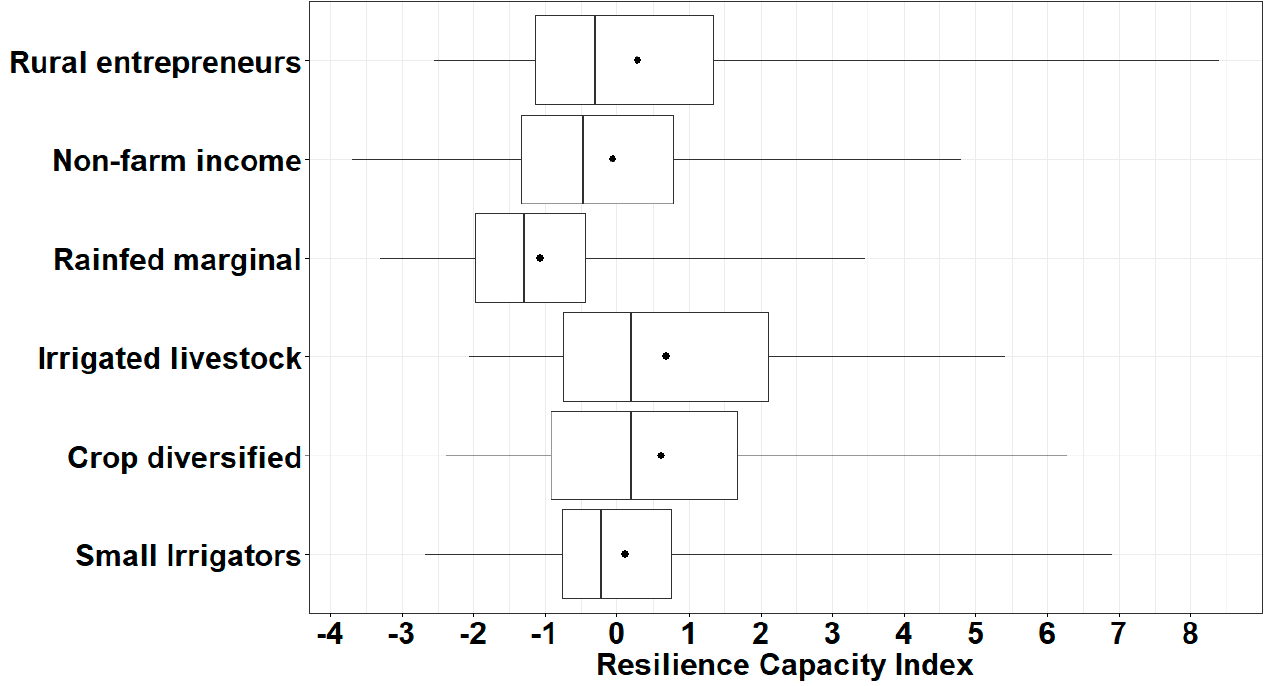
Figure 4. Comparison of resilience capacity across livelihood strategies (black dots indicate the mean and vertical lines indicate the median).